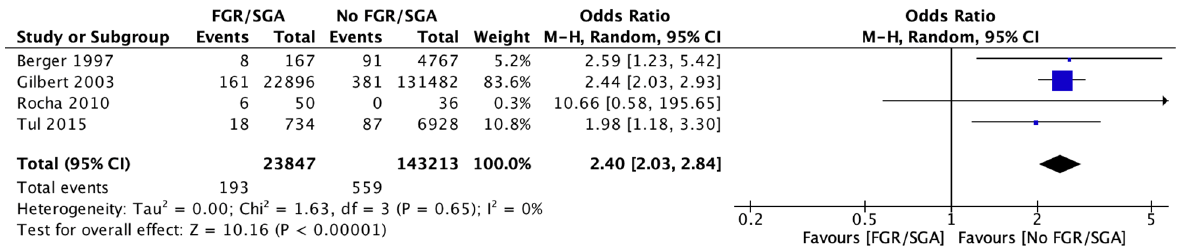
Figure 4. Forest plot comparing the risk intraventricular haemorrhage among babies with fetal growth restriction compared to babies without fetal growth restriction among all infants more than 32 weeks.